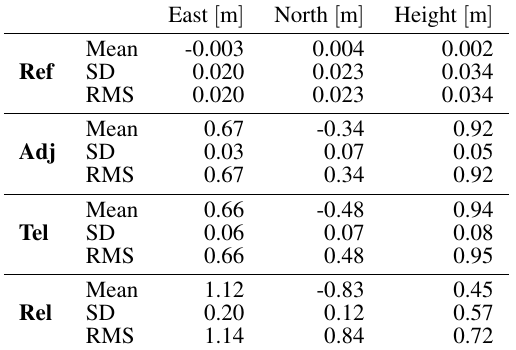
Table 3. Statistics of the differences between the GCPs/CPs coordinates estimated by the reference (Ref), “adjusted” (Adj), “telemetry” (Tel), and “relative” (Rel) solutions and those observed by the double-frequency GNSS receiver.